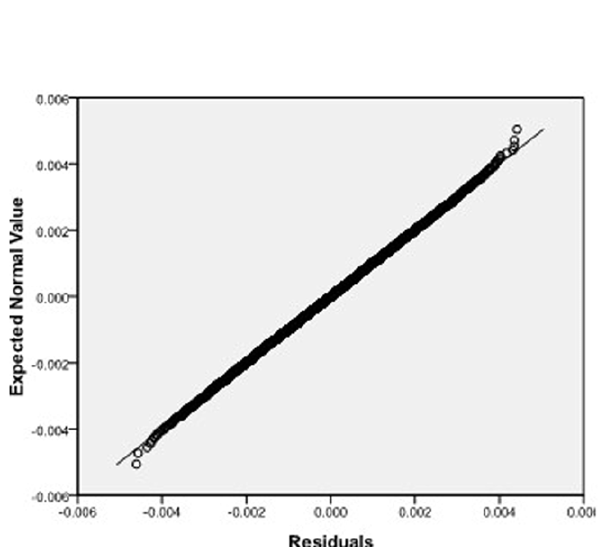
Figure 11. Histogram and asymptotic distribution for ^ bb 1 of OLS when the variance function of the error term is s 2 ( x 1 , x 2 ) ~ exp ( { ( x 1 z x 2 )) .